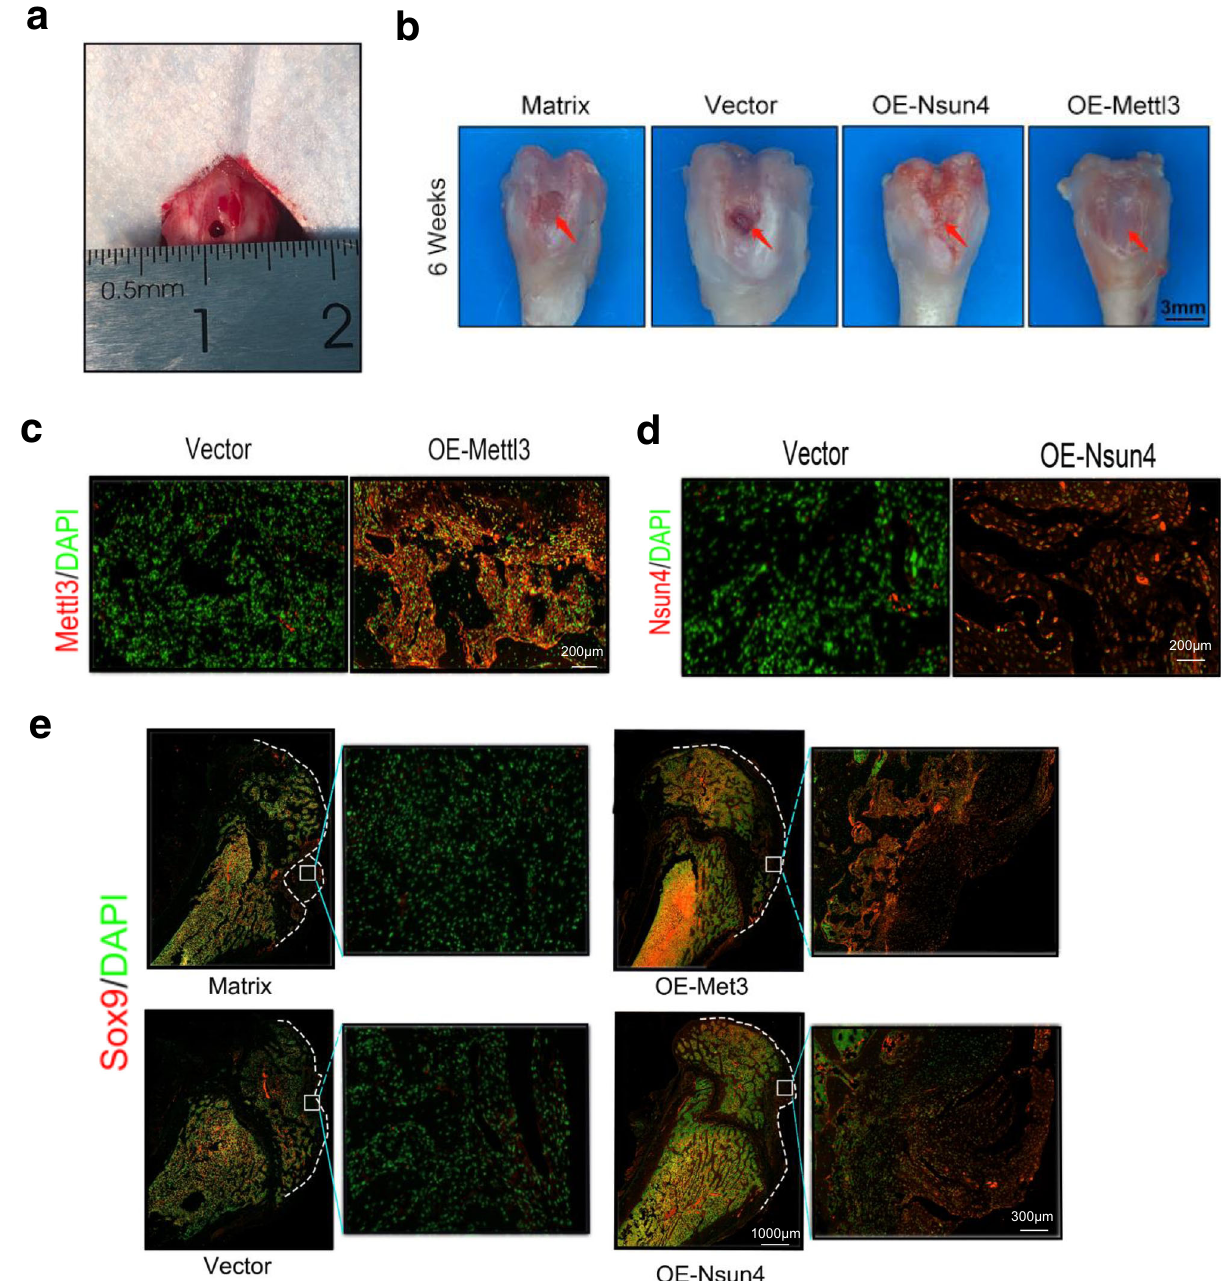
Fig. 6 Nsun4 and Mettl3 promote chondrogenic differentiation progression in vivo. a A 3-mm chondral defect was created in the medical area of the patella groove. b BMSCs infected vector/Nsun4-OE/Mettl3-OE adeno-associated virus for 7days, then were transferred to the defects for six weeks. Cartilage defects repaired in the Nsun4-OE and Mettl3-OE groups. Scale bars indicate 3 mm. c , d Veri fi cation of the ef fi ciency of Nsun4 ( c ) and Mettl3 ( d ) overexpression at the protein level in BMSCs on 6 weeks after Nsun4-OE and Mettl3-OE adeno-associated virus infection, as detected by immuno fl uorescence. n = 3. e Sox9 protein expression of repaired cartilage visualized through immuno fl uorescence at six